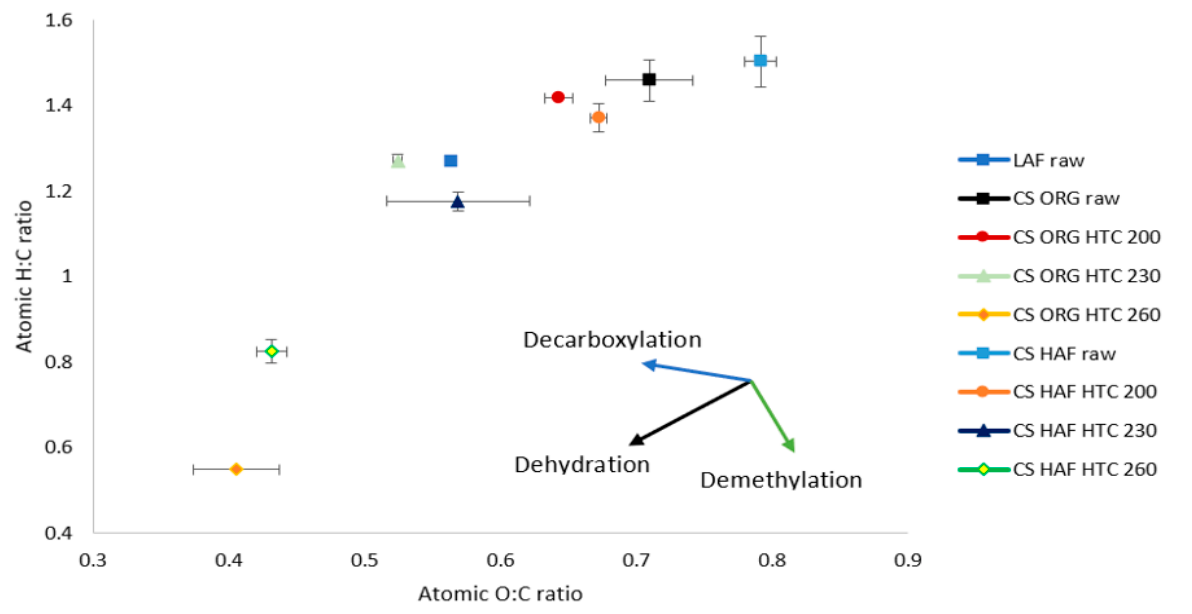
Figure 2. van-Krevelen diagram . Figure 2. Van-Krevelen